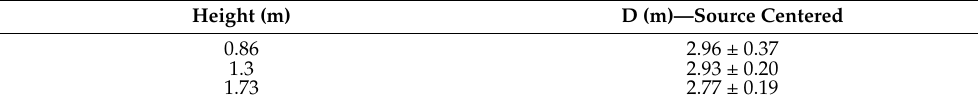
Table 9. Average and SD of the distance (D) between the estimated position of the source (using MLE algorithm) and the true source position using the EJ-200 scintillator gamma-ray count rate measurements considering the Troxler equipment oriented 90 ◦ (collimated 215 MBq 137 Cs source exposed—first notch after safe position) in the center of the shipping container.